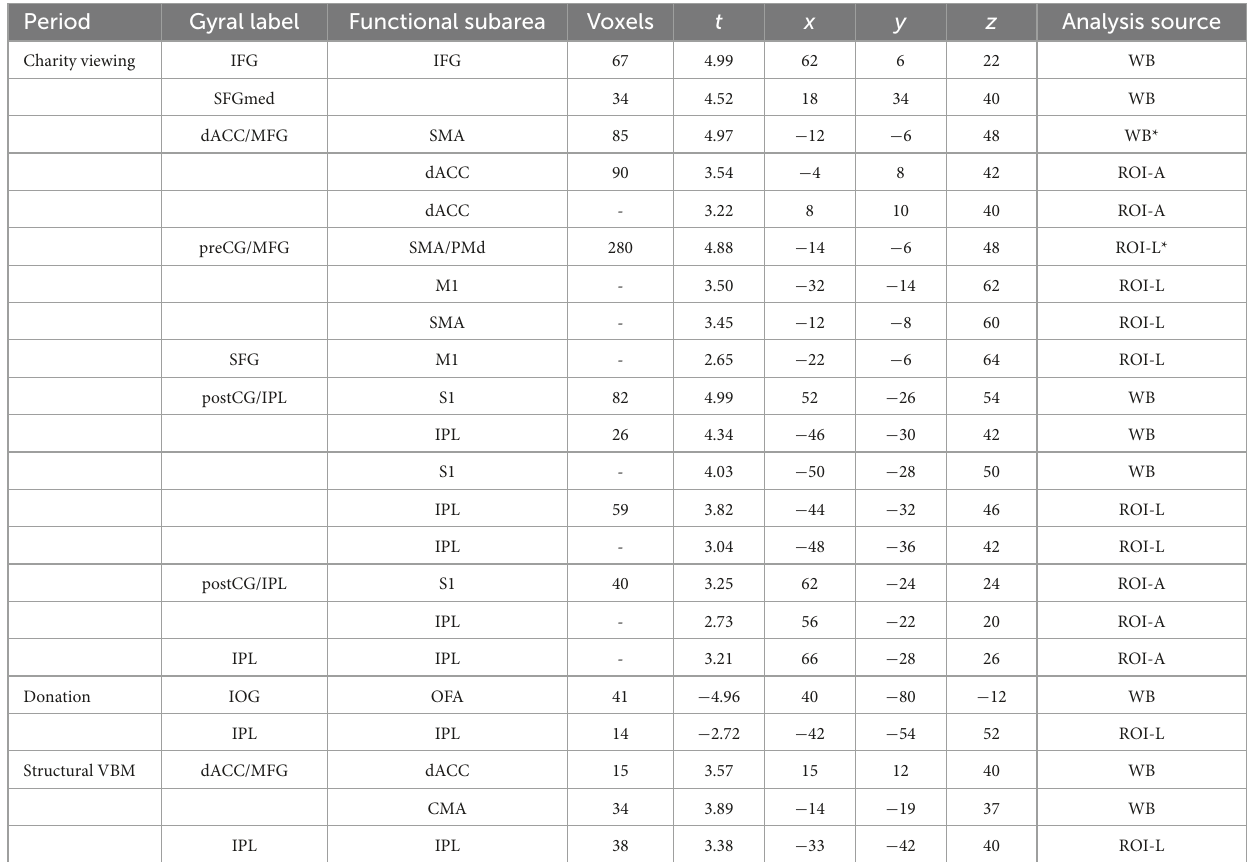
TABLE 1 Brain areas associated with the three-way behavioral donation interaction.